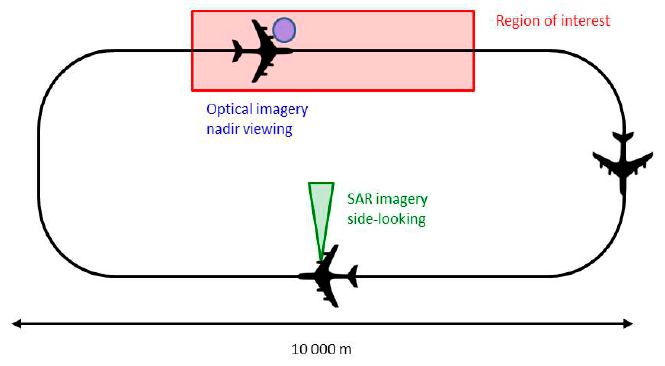
Figure 8. Trajectory followed by the SETHI multi-sensors during the NOFO OOW’2015 experiment. Table 4. Remote sensing data acquired by SETHI during the MOS Sweeper trial (9 June 2015). Data investigated herein appear in bold letters.